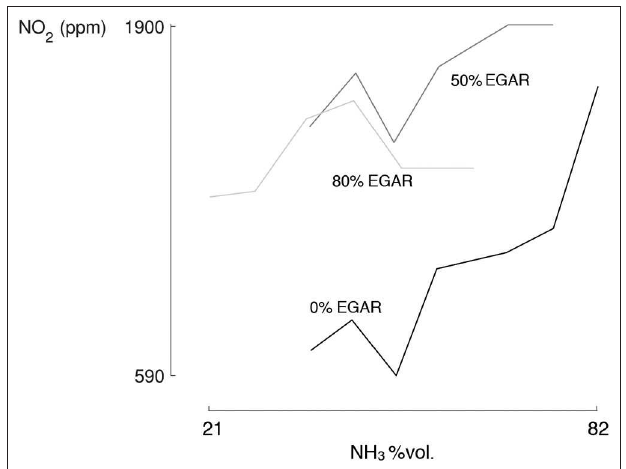
FIGURE 22 | NO 2 emissions increase as the ammonia fraction is raised, and the EGAR impacts them negatively (set #8 with a constant equivalence ratio of